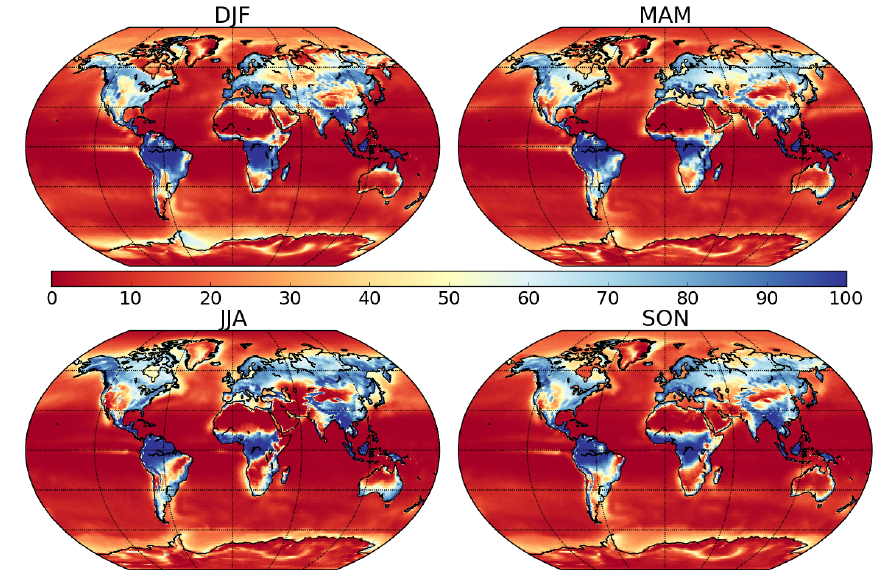
Figure 4. Seasonal occurrence of dew as a fraction of days (%).